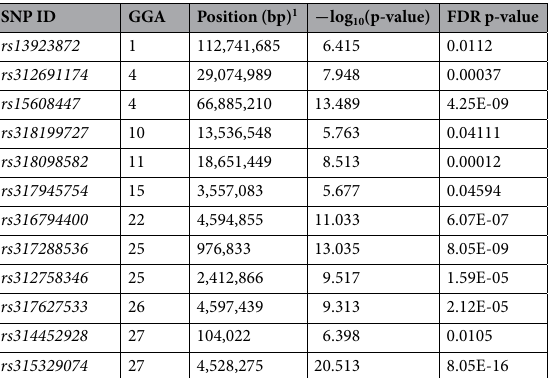
Table 1. Genome-wide significant SNPs (FDR p-value < 0.05) for BW. 1 Positions are based on Gallus gallus-5.0 genome